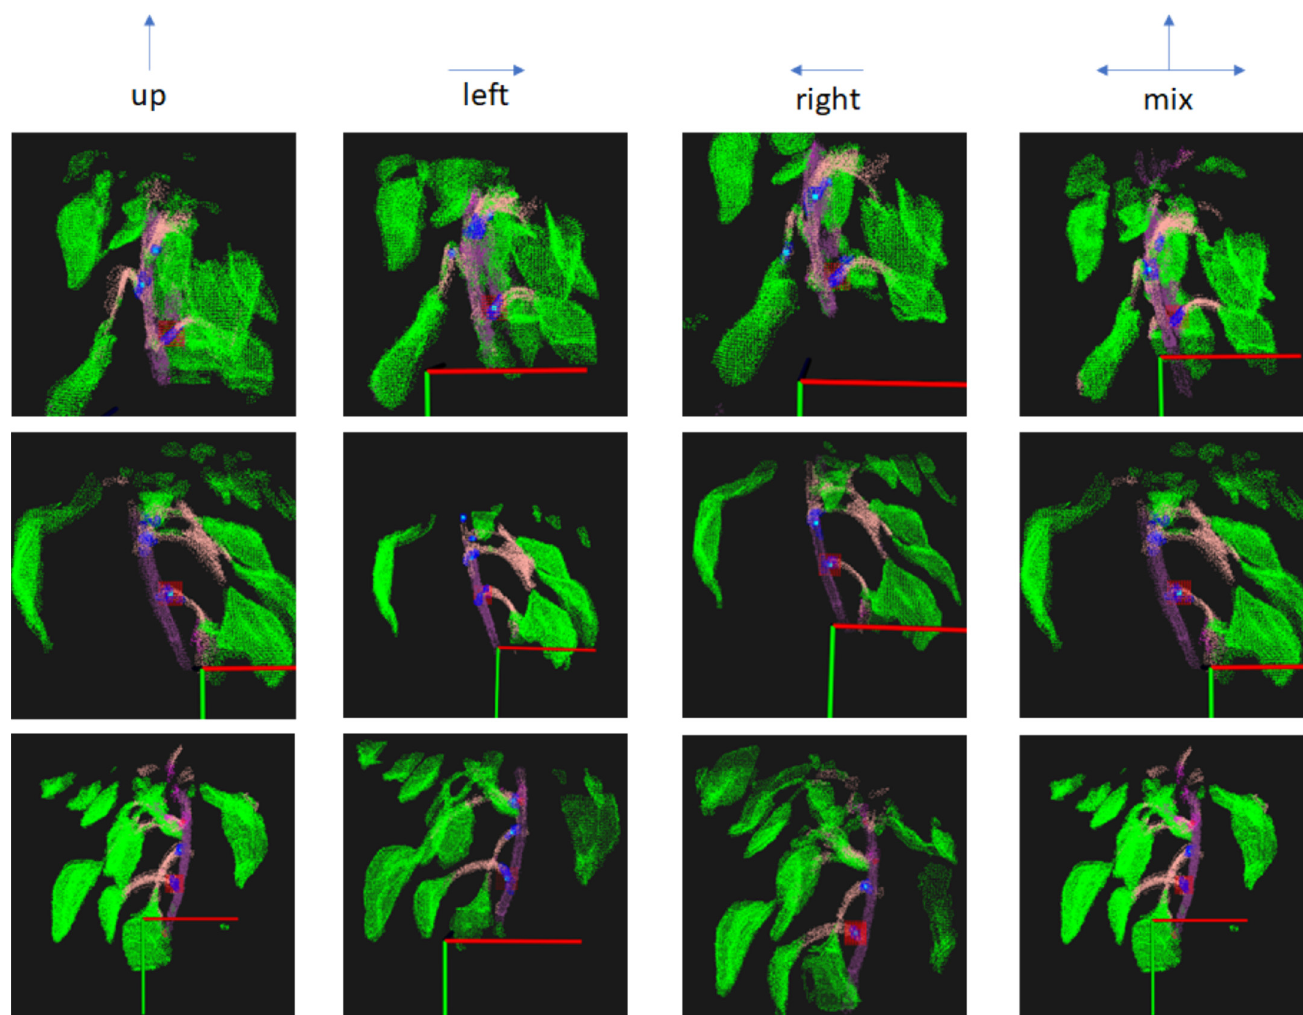
Figure 11. The images of twelve-point clouds were created through experiments. The pruning points were a light blue dot surrounded by a red area to be recognized easily by human eyes. The red, green, and black lines represent X, Y, and Z axes in a 3D coordinate system.